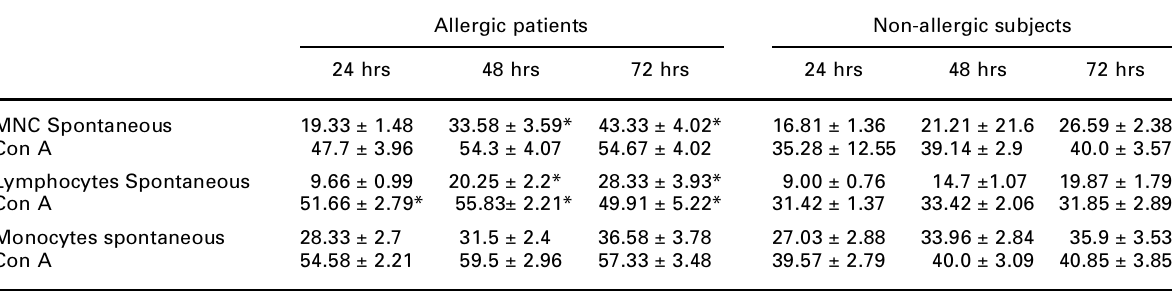
Table 2. Spontaneous and Con A stimulated apoptosis of MNC in allergic ( n = 12) and non-allergic subjects ( n = 16).